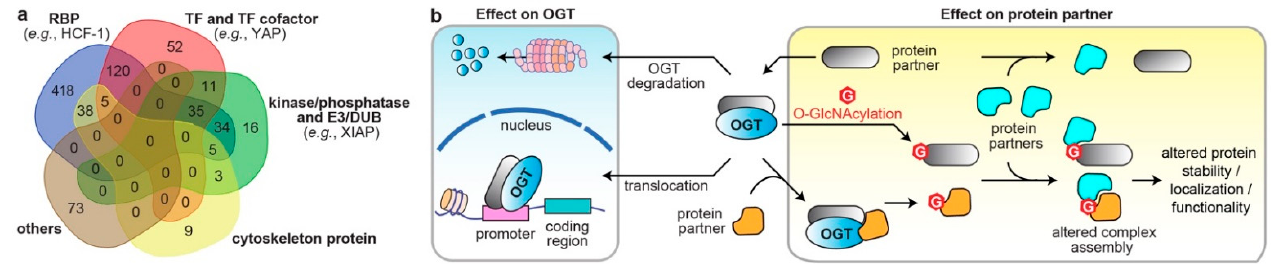
Figure 4. The diverse molecular impacts of protein interactions with O-GlcNAc cycling enzymes. ( a ) Classification of reported OGT/OGA binding partners in cancer. The information of OGT and OGA binding partners was from database OGT-PIN (high-stringency interaction proteins) and PINA, respectively. The binding partners were categorized using the databases AnimalTFDB 3.0 and